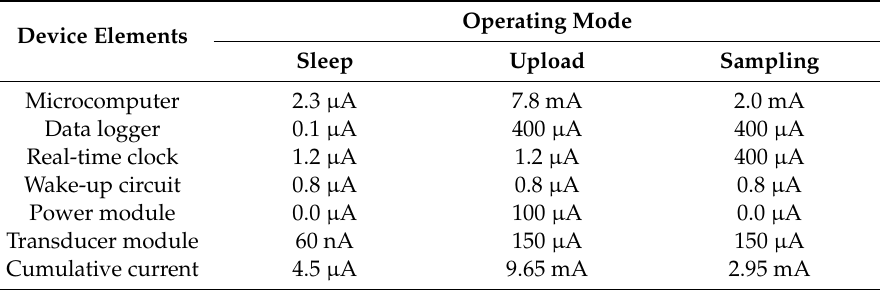
Table 2. ESC di ff erent structures with the power consumption of each device according to the operating mode in